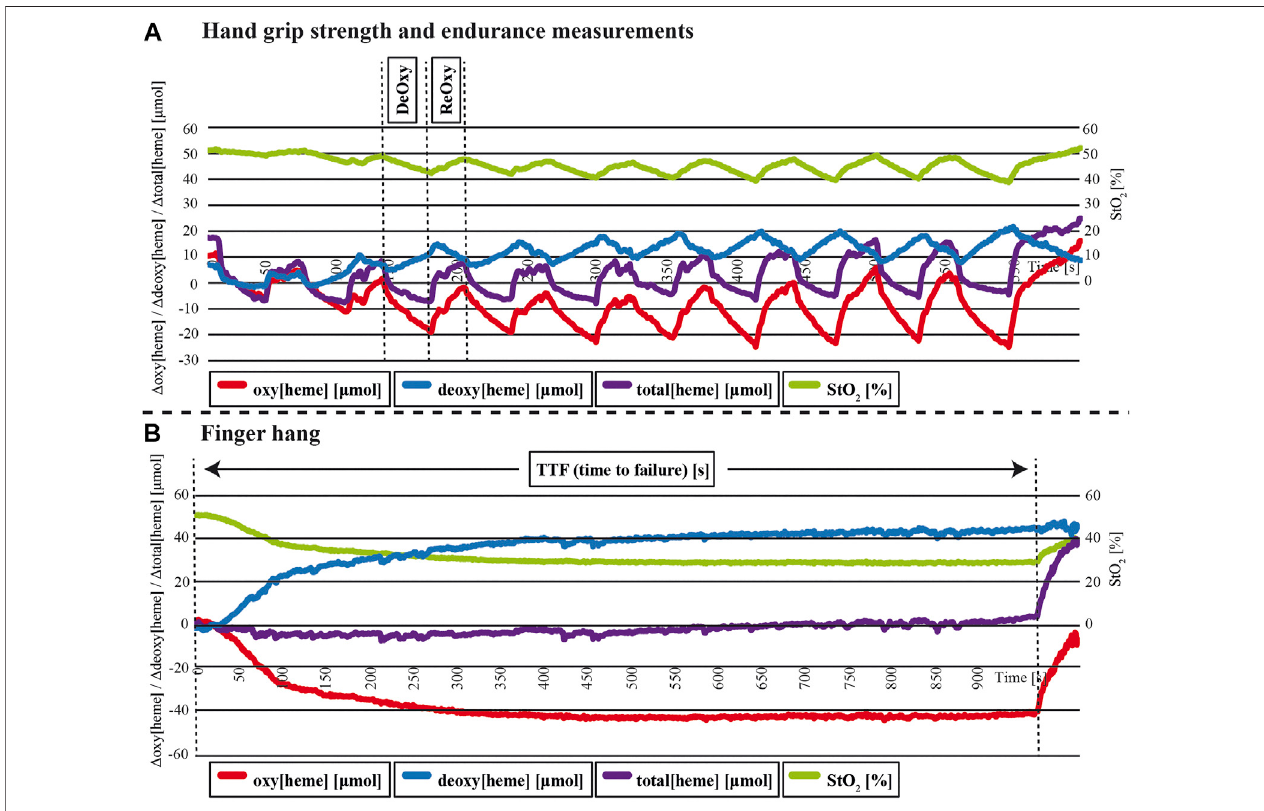
FIGURE 2 | Representative changes in tissue oxygen saturation (StO 2 ), oxygenated (oxy[heme]), deoxygenated (deoxy[heme]), and total (total[heme]) [heme] during hand grip strength and endurance (A) and fi nger hang (B) measurements.